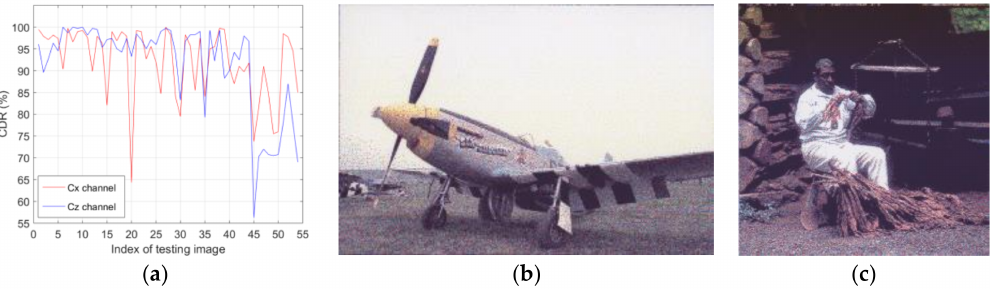
Figure 7. ( a ) CDR from 600 dpi scans of all testing images; ( b ) 600 dpi scan of the 20th testing image; ( c ) 600 dpi scan of the 45th testing image.